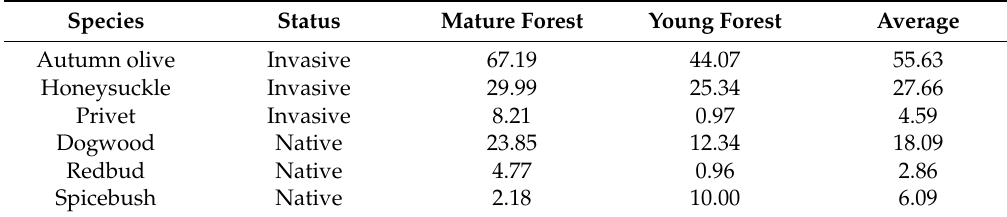
Table A1. Average germination (%) of seeds for each species in each forest age and overall.